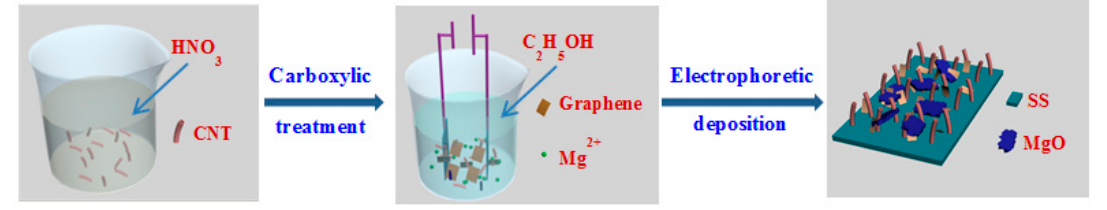
Figure 1. Production process of carbon nanotube CNT-Graphene hybrid .